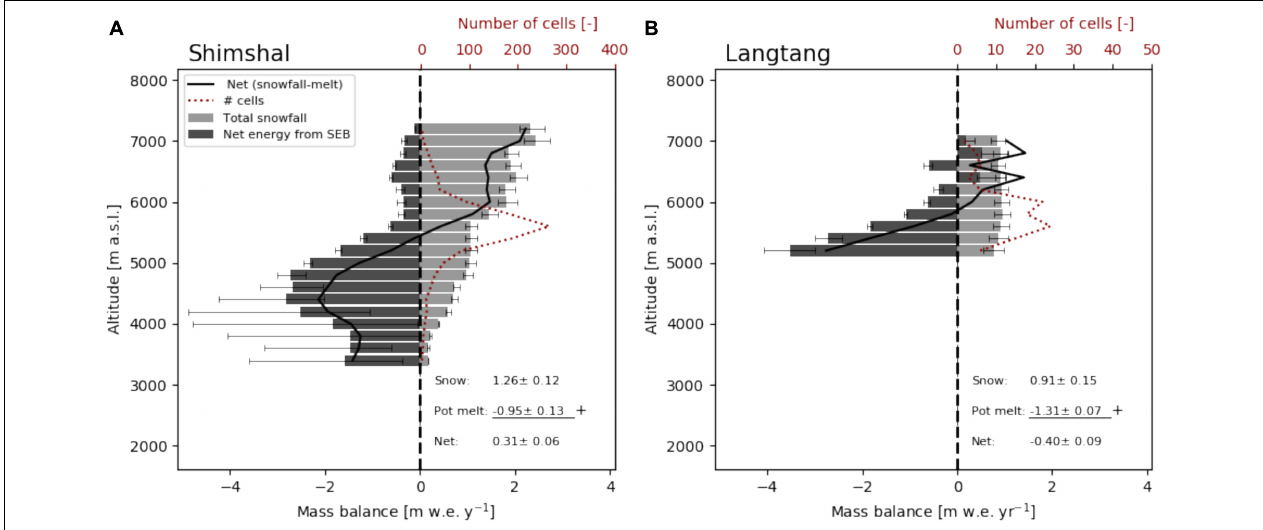
FIGURE 11 | Normalized mass balance (black line) with altitude for Shimshal (A) and Langtang (B) . Snow (light gray) and melt caused by residual energy (dark gray). Each bin represents an average of that altitude range. The red dashed line indicates the amount of cells. Error bars indicate the variability between simulated years. Numbers indicate the average snow (snow), residual energy flux (pot melt), and total mass balance (net) over 2011–2013.